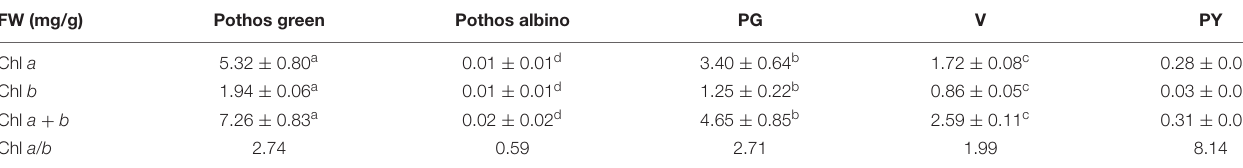
TABLE 2 | Chlorophyll a and b